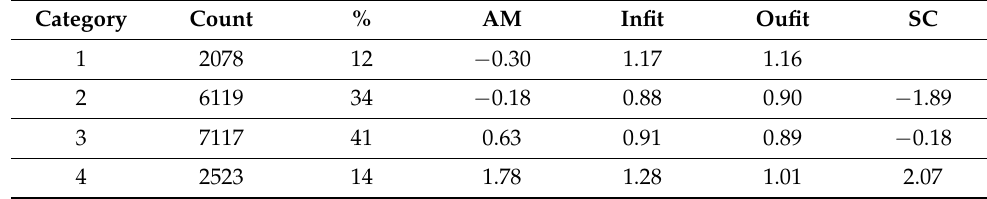
Table 7. Verification of the 4-point Likert Scale’s Appropriateness.